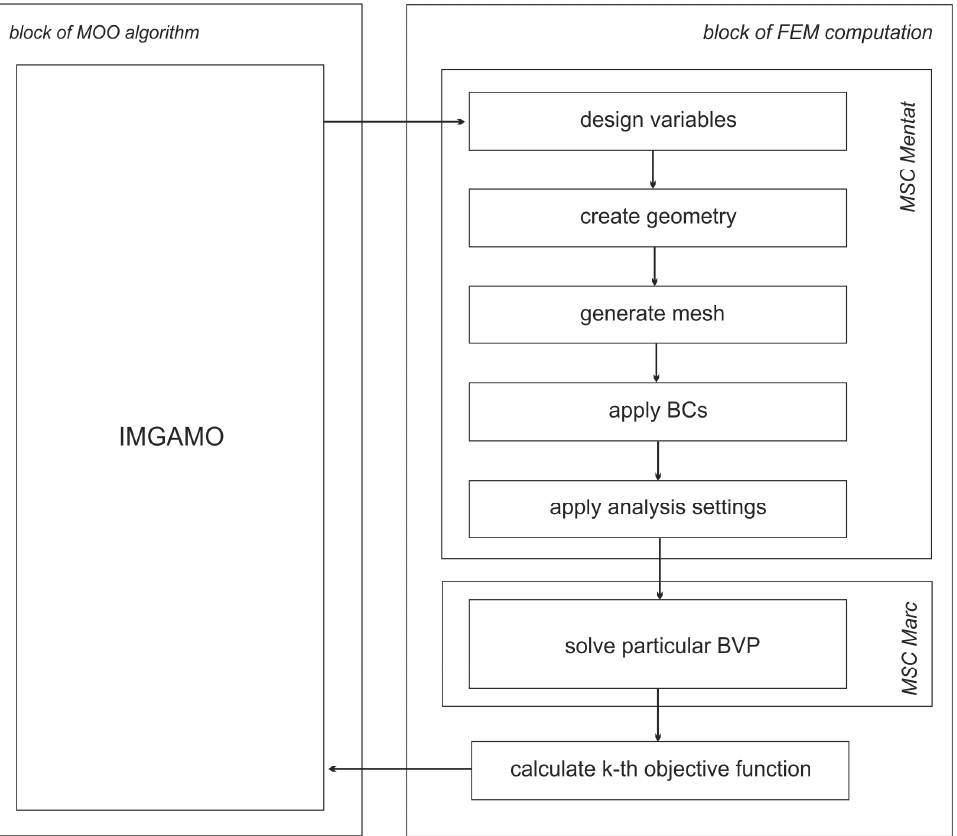
Figure 10. General schema of optimal design system for electrothermal microactuators.